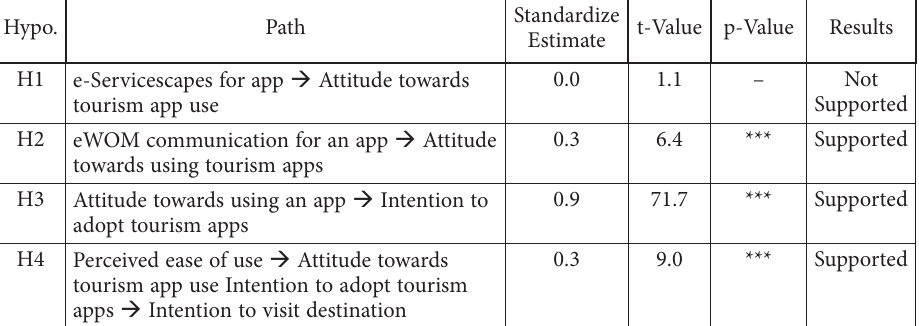
Table 3. Evaluation of structural model and hypothesis testing